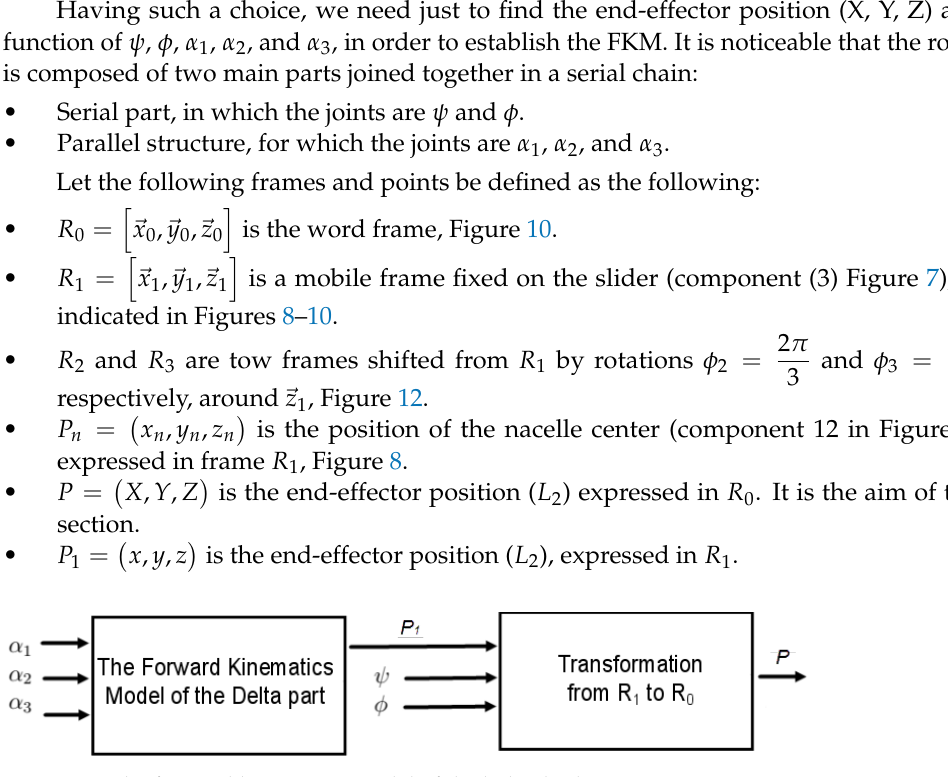
Figure 11. The forward kinematics model of the hybrid